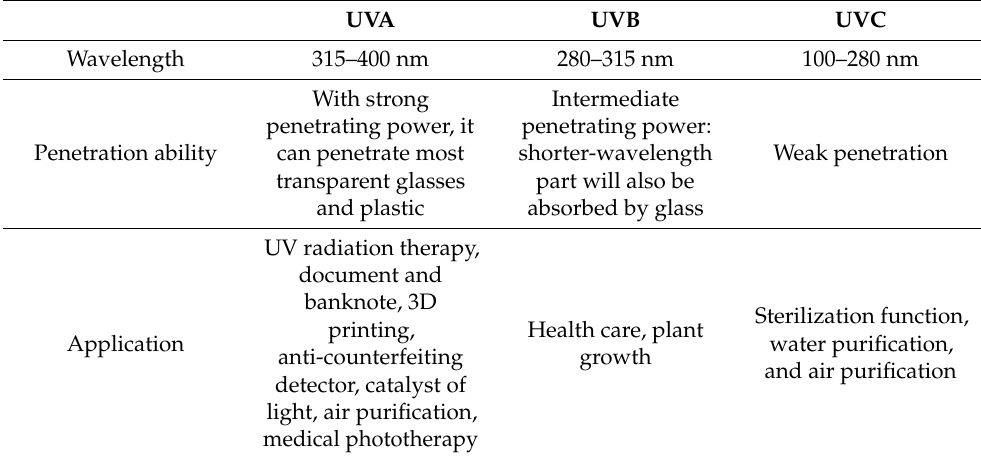
Table 1. Summary of applications of UVA, UVB, and UVC LEDs